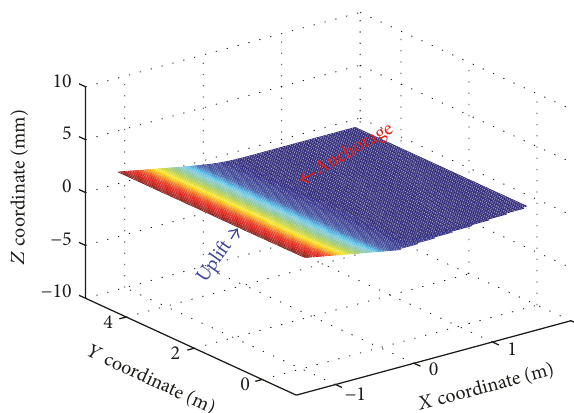
Figure 14: The uplifted area of the foundation plate.